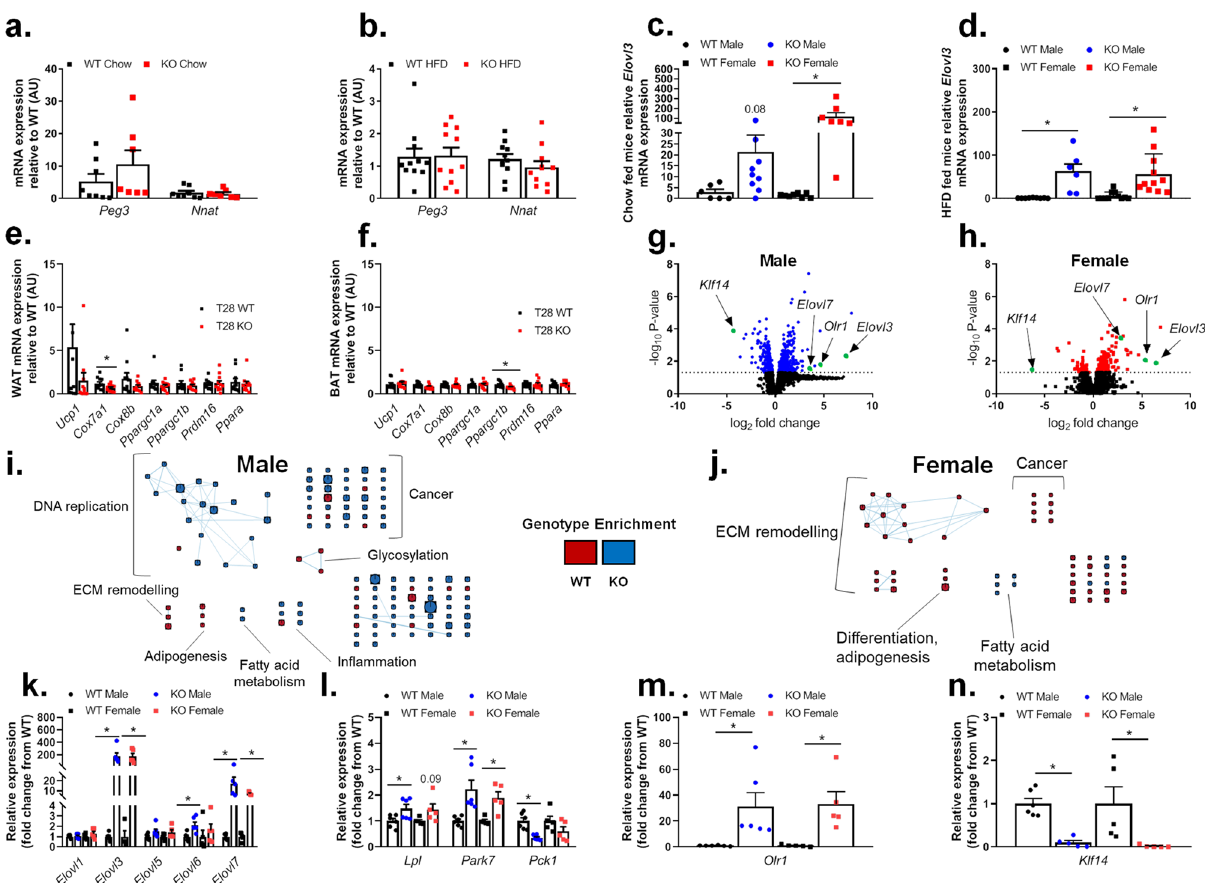
Fig. 7 Trim28 adi-KO alters metabolic gene expression in WAT. Gene expression analyses performed in gonadal fat pads from female Trim28 wild type (WT) and adipose-speci fi c Trim28 KO (KO) mice fed either a chow or HFD. Imprinted gene network 1 (IGN1) genes Peg3 and Nnat mRNA expression in ( a ) chow fed, n = 8 WT and n = 7 KO, and ( b ) HFD-fed mice as determined by qPCR, n = 11/group. Elovl3 mRNA expression in male and female ( c ) chow-fed mice n = 6 M-WT and n = 10 M-KO, n = 8 F-WT, n = 7 F-KO, and ( d ) HFD-fed mice n = 9 M-WT and n = 7 M-KO, n = 11 F-WT, n = 11 F-KO. qPCR analysis of gene expression for ( e ) browning of WAT n = 10 WT and n = 11 KO, and ( f ) surrogate markers of BAT activity n = 10 WT and n = 11 KO. Volcano plots of differentially expressed genes regulated between chow-fed WT and Trim28 adi-KO mice as determined by RNAseq analysis in gonadal adipose tissue from ( g ) male mice and ( h ) female mice. Functional map of genes enriched in WAT from chow-fed Trim28 WT (red) and adi-KO (blue) mice in ( i ) male and ( j ) female mice. Enrichment results underwent MSigDB pathway analysis to determine enriched pathways. Gene sets were related by mutual overlap (edge width), where node size is proportional to the total number of genes in each set. Abundance of transcripts determined from RNAseq in WAT of WT and Trim28 adi-KO mice for ( k ) Elovl family members, and signi fi cantly regulated metabolic genes ( l ) Lpl , Park7 , and Pck1 , ( m ) Olr1 and ( n ) Klf14 , (RNAseq: males; n = 6, females; n = 5). All data are represented as mean ± SEM, * p < 0.05 versus WT mice. RNA-seq data were analyzed using ANOVA with FDR correction (Benjamini Hochberg). Speci fi c gene comparisons were analyzed by ANOVA with post hoc testing (Fisher ’